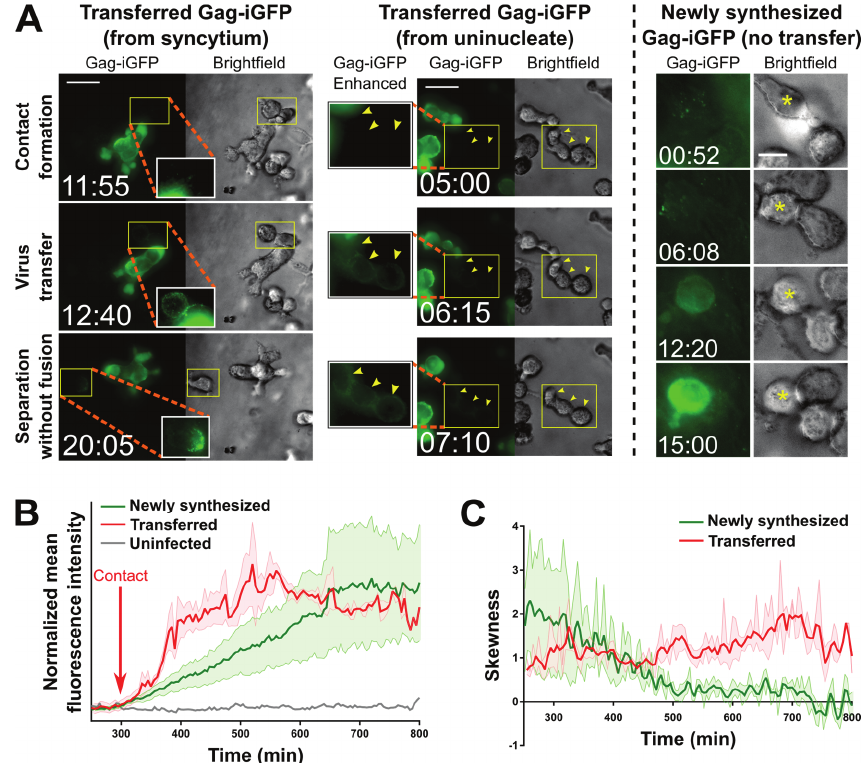
Figure 3. Transfer of virus particles from HIV-1 NL4-3 Gag-iGFP -infected uninucleated CEM-SS cells and CEM-SS syncytia to uninfected CEM-SS cells in 3D ECM hydrogels. ( A ) (Left); A syncytium with 3 nuclei transfers virus to target cells, one of which then migrates away (see also Movie S7). (Middle); A uninucleated infected cell transfers virus to three target cells (yellow arrowheads; see also Movie S6). (Right): An uninfected cell with Gag-iGFP puncta on its surface (asterisk) begins developing newly synthesized Gag-iGFP signal ~12 h later, while a cell it is attached to throughout this time that did not harbor Gag-iGFP puncta is not seen to develop Gag-iGFP signal. Scale bars = 30 μ m ((left) and (middle)) or 10 μ m (right). Elapsed time in hours:minutes. Gag-iGFP signal is pseudocolored in green. Brightfield images are in shades of gray. To show transferred virus particles more clearly, the areas indicated by yellow boxes are shown in white-boxed enhanced insets with 1.5× enlargement and a 0.6 gamma correction applied; ( B ) Average of the mean fluorescence intensities of five target cells exhibiting either transferred Gag-iGFP (red), or five other target cells developing newly synthesized Gag-iGFP from a previously unseen infection event (green). An uninfected cell is shown in grey. The individual traces were aligned according to the time where Gag-iGFP signal began increasing (which was the time of contact with the producer cell in all cases for the transfer traces; red arrow), and the averaged curves were manually normalized to baseline and smoothed (2nd order and 2 nearest neighbors); ( C ) The average skewness of the signal across these same cells was plotted. Skewness close to zero indicates evenly distributed, or hazy signal, while higher positive skewness indicates punctate signal. Error boundaries in (B,C) represent the standard error of the mean.